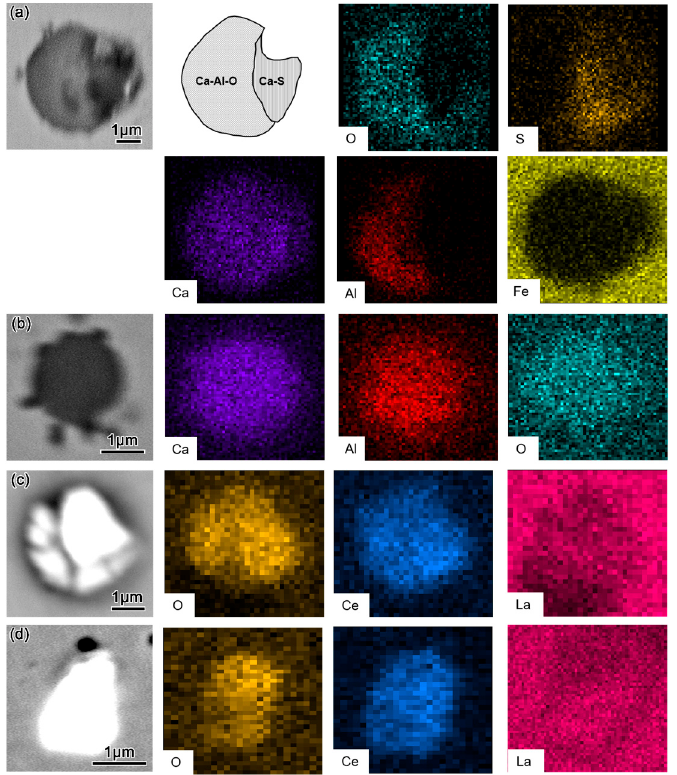
Figure 9. Typical morphology of inclusions in industrial billet ( a , b ) without a rare earth compound and ( c , d ) with the addition of a rare earth compound.